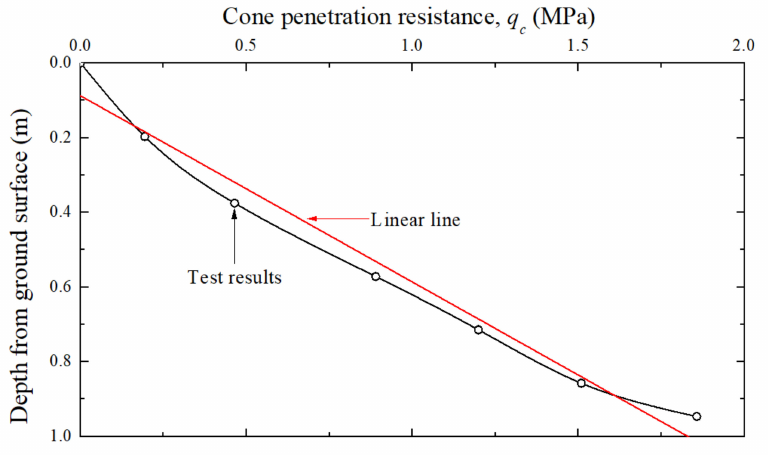
Figure 6. Conformity analysis of homogeneous ground through cone penetration test.